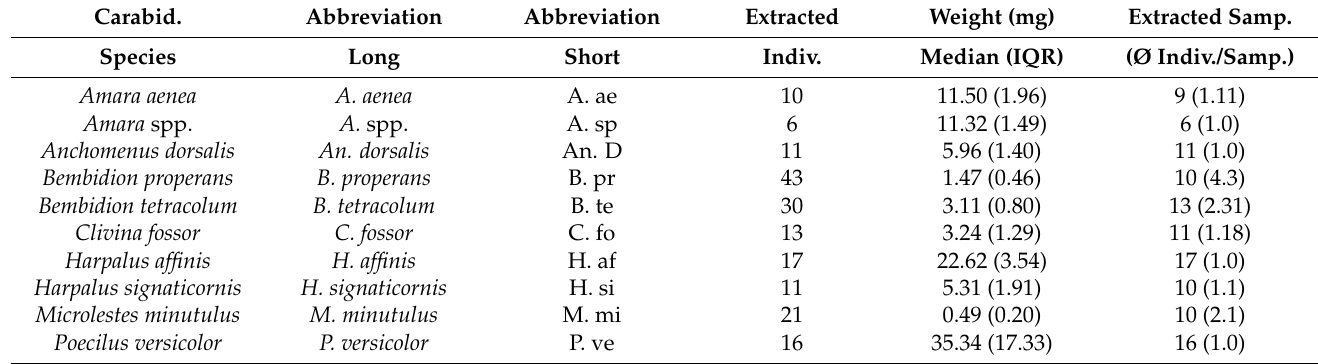
Table 2. Number of individuals (Indiv.) of carabid species used for DNA extraction, their body weights in mg (median and interquartile range, IQR) and the number of samples used for DNA extraction, and the average (Ø) number of individuals per sample in the molecular biological